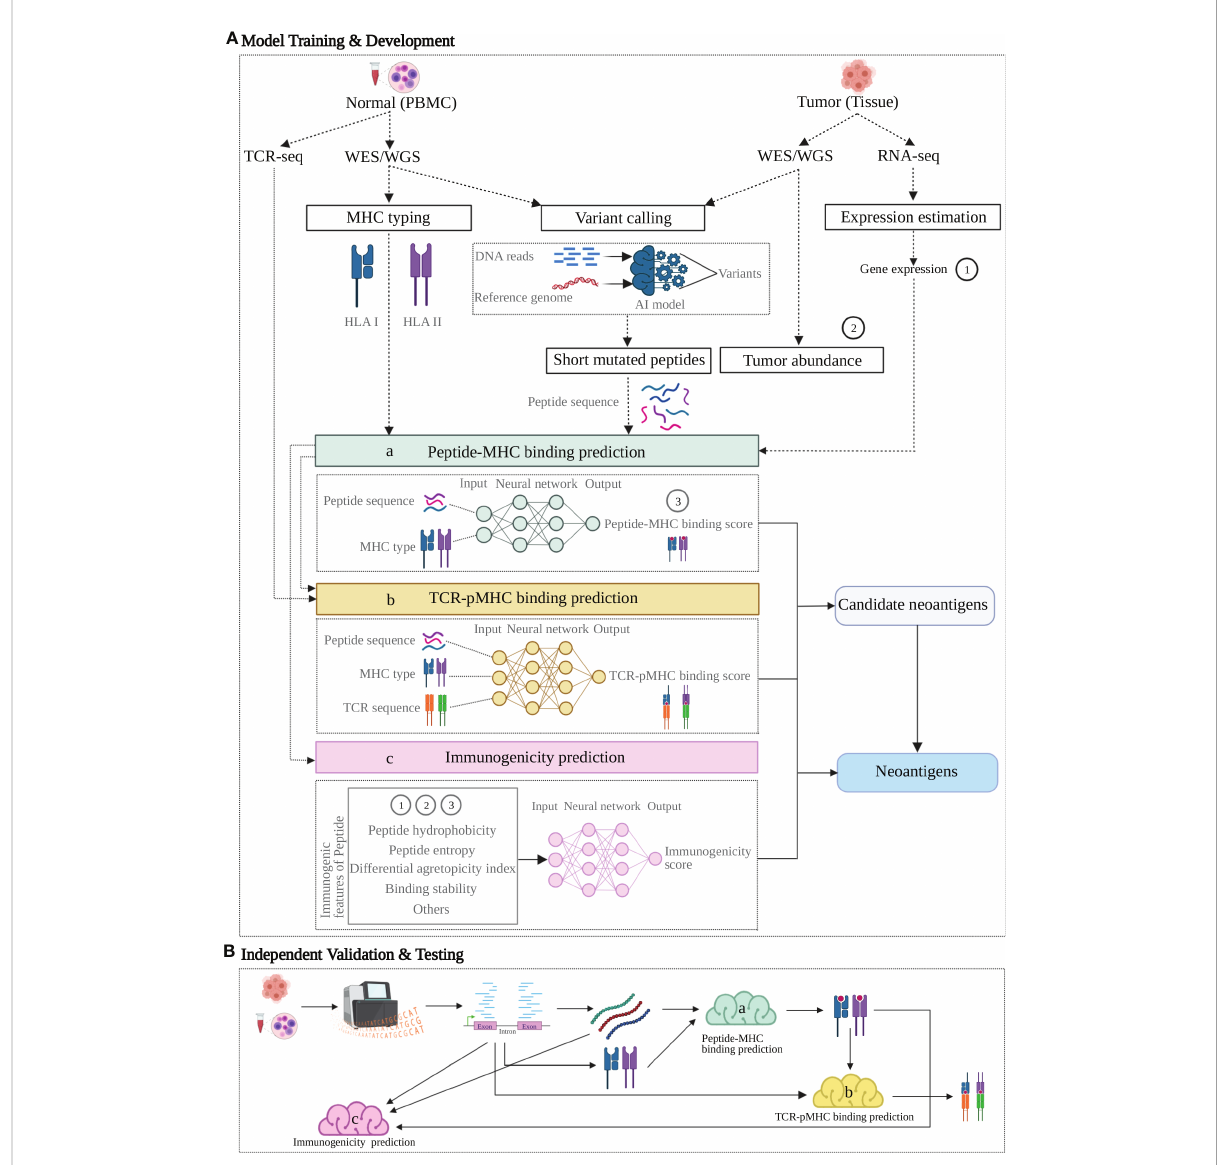
FIGURE 2 A proposed neoantigen-predicting work fl ow implemented with machine learning (ML) models targeting individual characteristics. A group of veri fi ed neoantigen data is split into two datasets for Training + Development and Testing respectively. (A) Upper dotted line box: Model Training and Development. 1) individual features of the training data with known class (positive or negative for neoantigen) are either produced from NGS pro fi ling directly or indirectly as additional rounds of analysis may apply to generate the variables; 2) as indicated by dashed arrow lines, these feature variables act as input in three ML models (colored boxes) targeting three characteristics: peptide-MHC binding (model a, sapphire), TCR-pMHC binding (model b, yellow) and Immunogenicity (model c, pink); 3) as indicated by the arrow lines, each model learns from its own input data and generate a prediction or together produces an integrated prediction; 4) ML model compare its prediction against the true class of the training data and learn from this training, following by optimization aiming for a better prediction. (B) Lower dotted line box: Independent Validation and Testing. After the predictive models trained and developed, a candidate neoantigen will undergo NGS-based genomic pro fi ling and generated input data, followed by processing in the three trained models (a-c, colored clouds) and eventually provide the predictions. Figure was created with